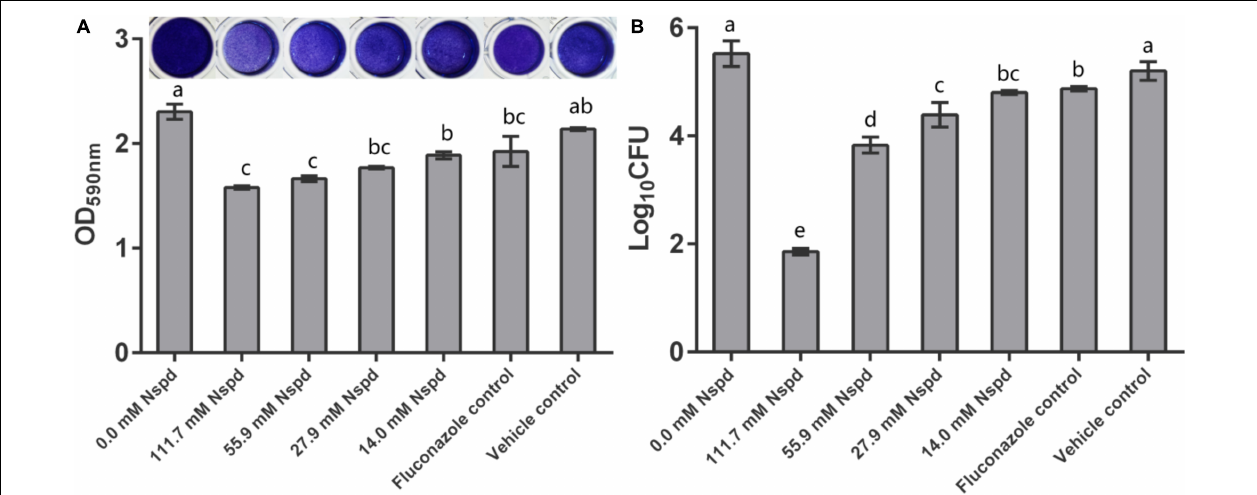
FIGURE 1 | C. albicans biofilm biomass determined by crystal violet assay and CFU count. (A) Quantitative analysis of biofilm biomass by crystal violet assay with inserted panel of representative C. albicans biofilm stained with crystal violet. 111.7 and 55.9 mM Nspd showed obvious removal effect on 48 h old mature fungal biofilms. Other Nspd, positive and vehicle controls showed moderate biofilm removal effect. (B) CFU count of C. albicans in biofilms after 48 h exposure to interventions. CFU counting indicated survival proportion of C. albicans in biofilm. 111.7 and 55.9 mM Nspd showed significant fungicidal effect on mature biofilms. Other Nspd and positive control groups showed mild fungicidal effect. Vehicle control, containing 0.08% ethanol, showed no fungicidal effect on mature biofilms. Data were presented in mean ± standard deviation and values with dissimilar letters were significantly different from each other; p < 0.05 .